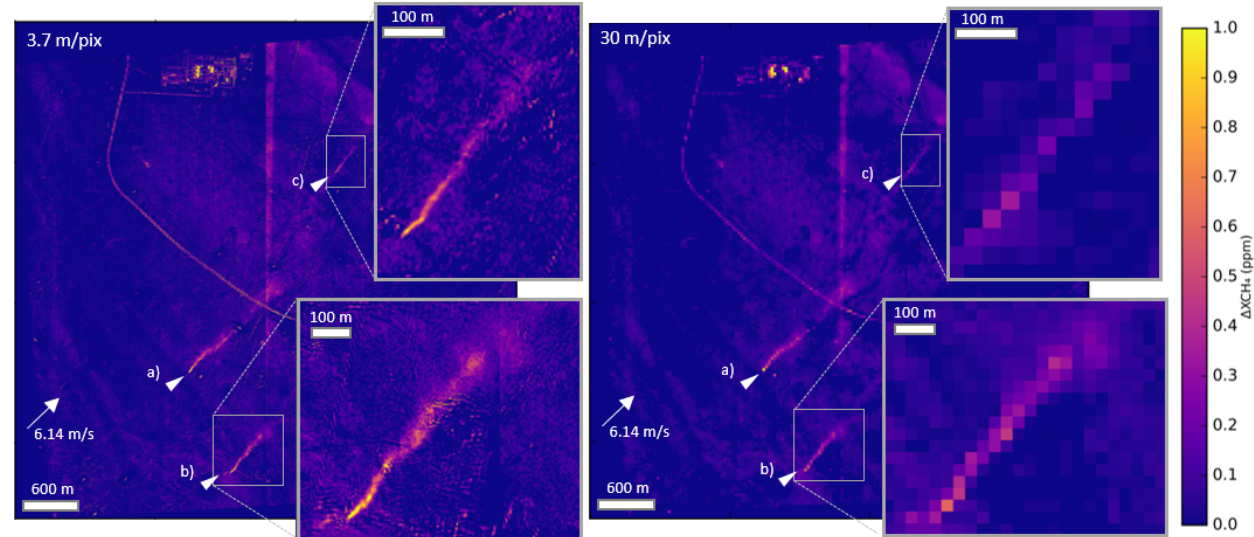
Figure 15. (cid:49) XCH 4 map for the image on 29 December 2020 over Algeria; Hassi Messaoud oil field. Methane emissions from pipelines in (a) 31.778 ◦ N, 5.995 ◦ E, (b) 31.768 ◦ N, 6.000 ◦ E and (c) 31.797 ◦ N, 6.011 ◦ E locations; the latter two zoomed. The left panel corresponds to the (cid:49) XCH 4 map derived from the real WV-3 image (3.7m per pixel), while the right panel shows the same map but resampled to 30m